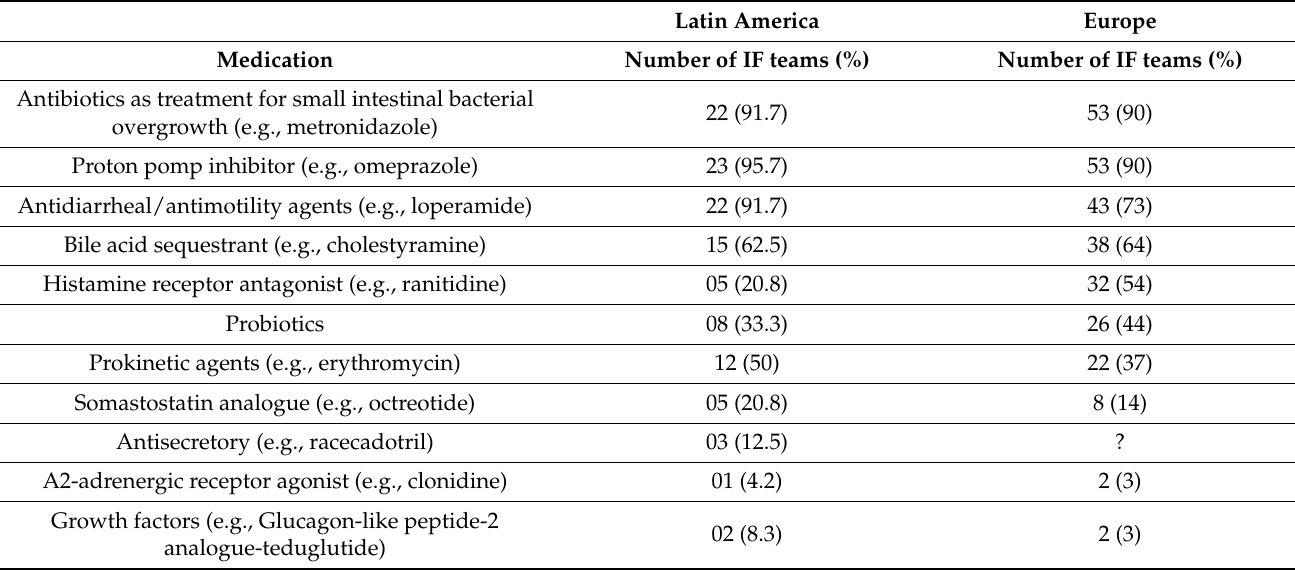
Table 5. Medications regularly used by the IF teams in Latin America and Europe